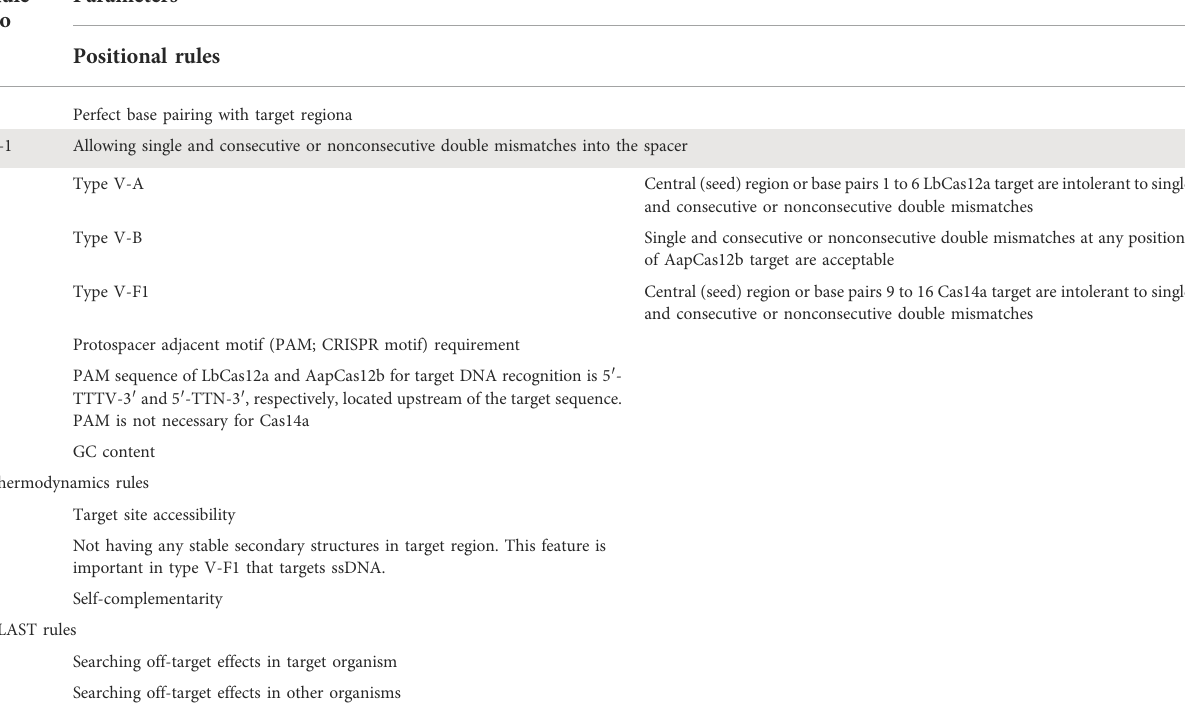
TABLE 4 Principles of crRNA designing for type V-A/B/F1 CRISPR-Cas